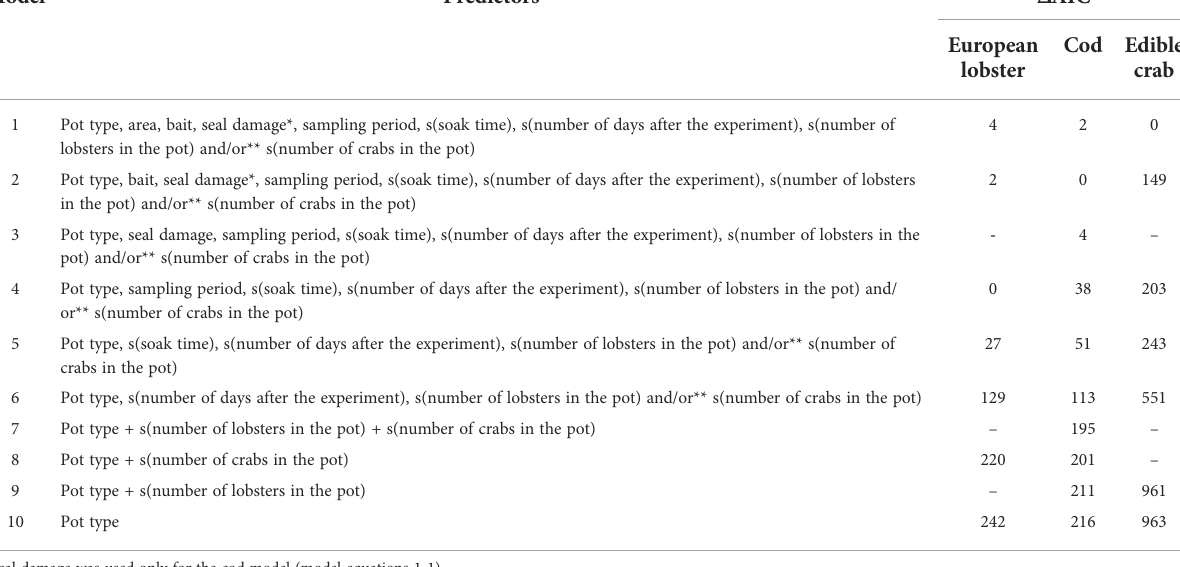
TABLE 5 Best-supported generalized additive models for factors affecting CPUE of cod/European lobster/edible